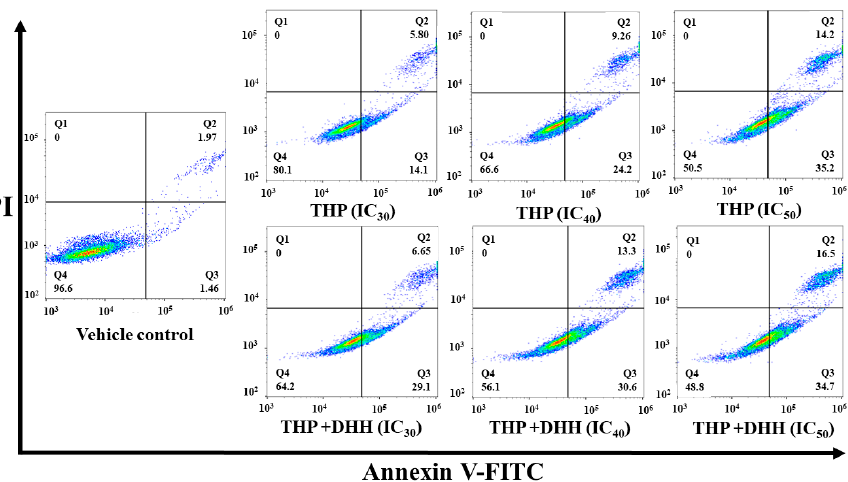
Figure 10. Effects of THP and THP combined with DHH on apoptosis induction in K562/ADR cells.